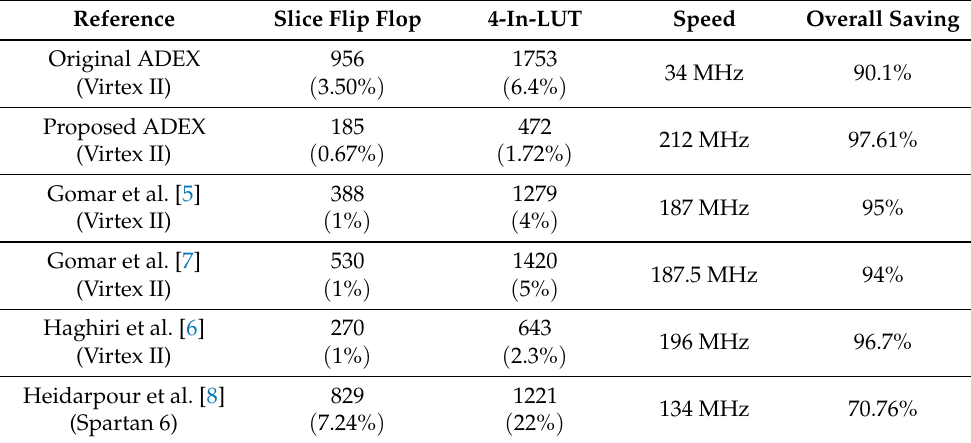
Table 7. Resource costs of FPGA hardware for neuron model implementation.